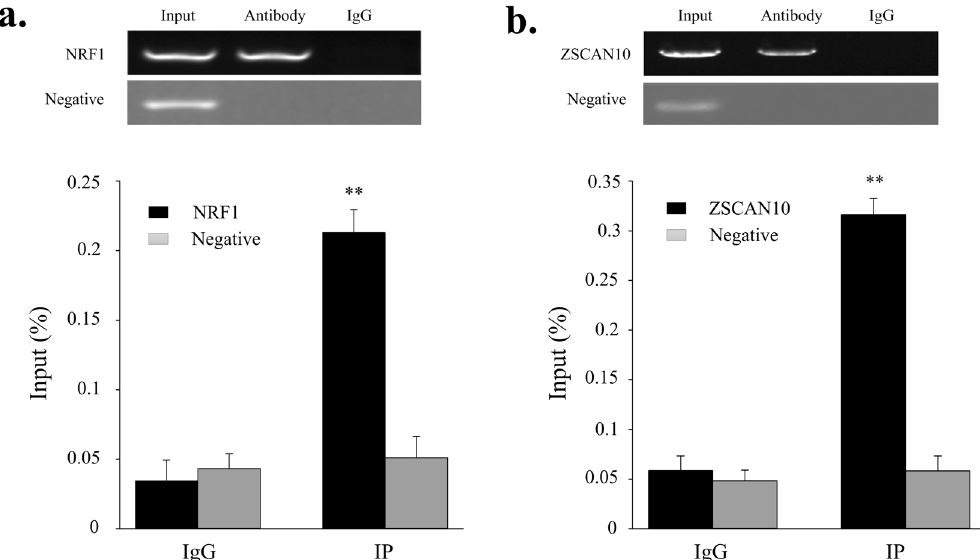
Figure 6. ChIP assay of NRF1 and ZSCAN10 binding to the SIX1 promoter in vivo . We analysed the immunoprecipitated products of the NRF1 ( a ) and ZSCAN10 ( b ) antibodies via RT-PCR and ChIP-QPCR. We used total chromatin from muscles as the input, and normal rabbit IgG served as the negative control antibody. “ ** ” P < 0.01. Error bars represent the SD (n =